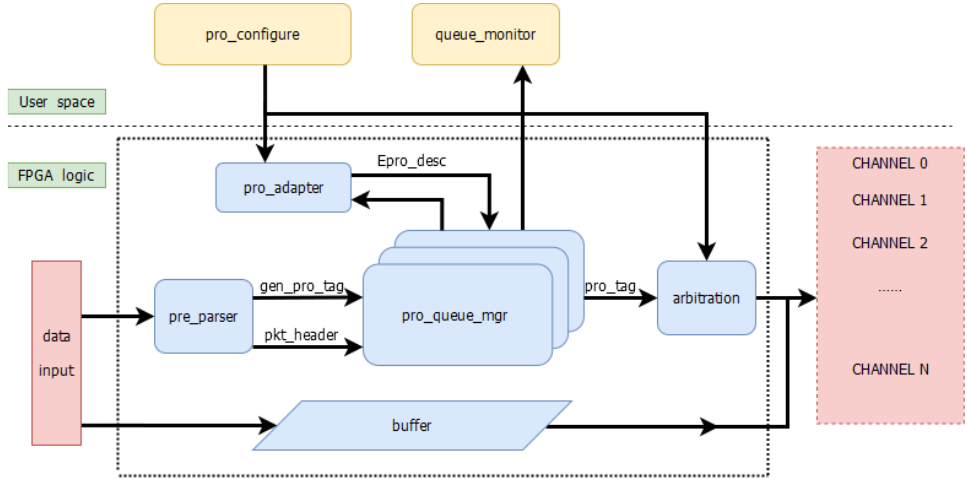
Figure 1. The abstract module of